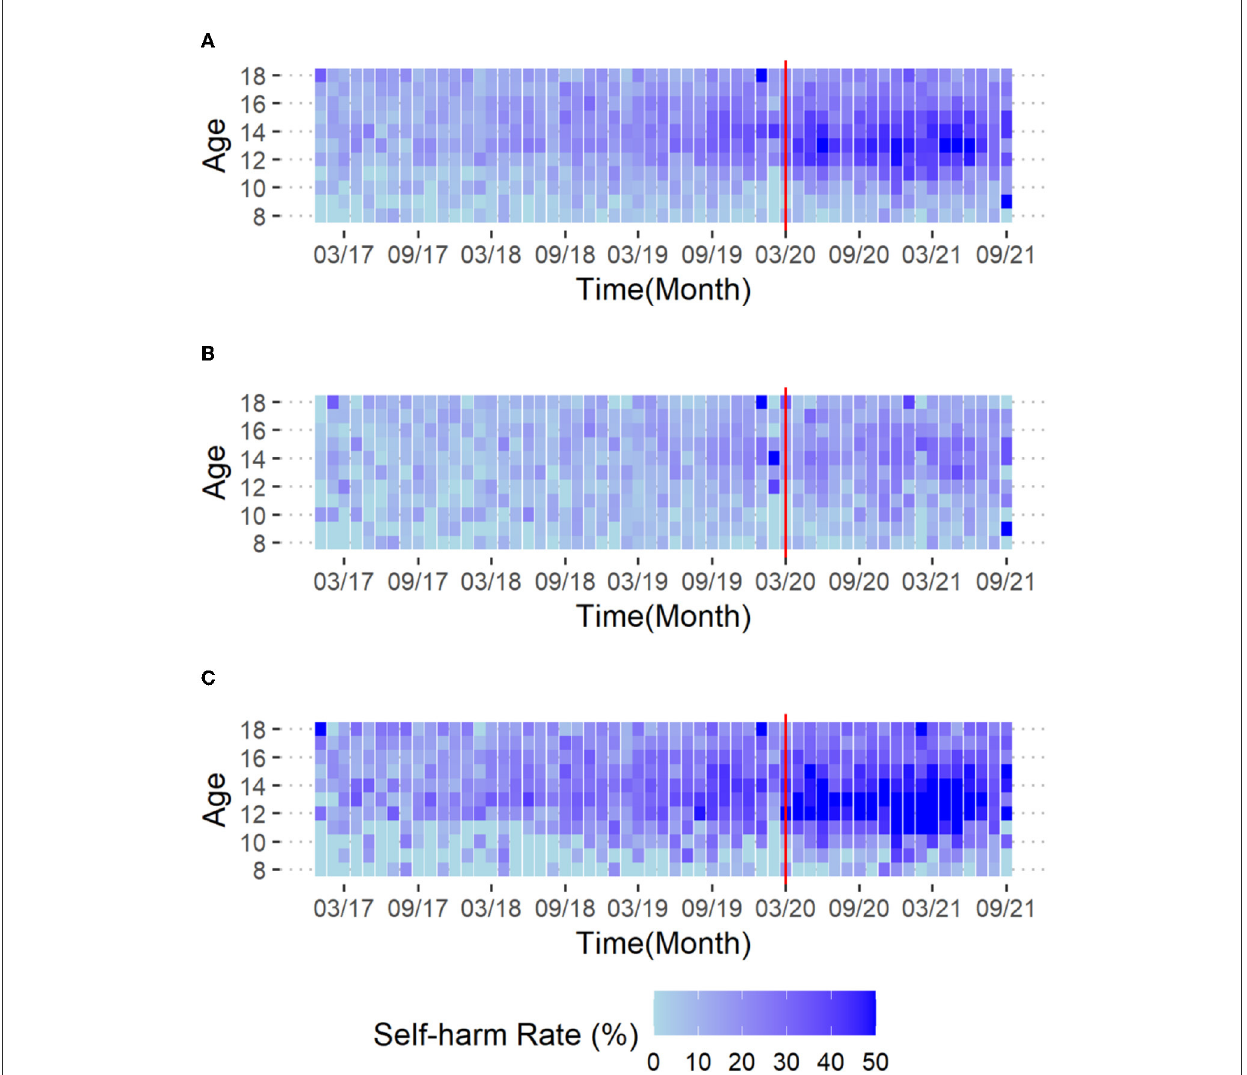
FIGURE2 Heat map of self-harm rates. (A) Entire sample, (B) male, and (C) female patients. The colors in the cells represent the self-harm rate for each age group in each month. The red vertical line indicates March 2020, from which time the adolescent’s social environment was affected (nation-wide home study